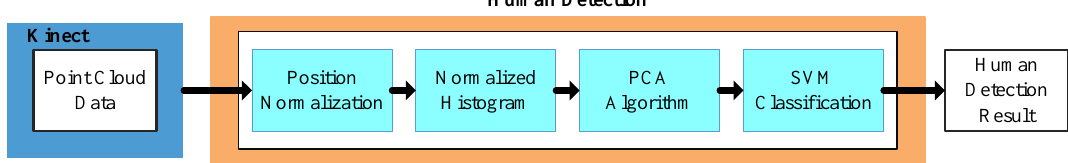
Figure 2. Block diagram of human detection process.